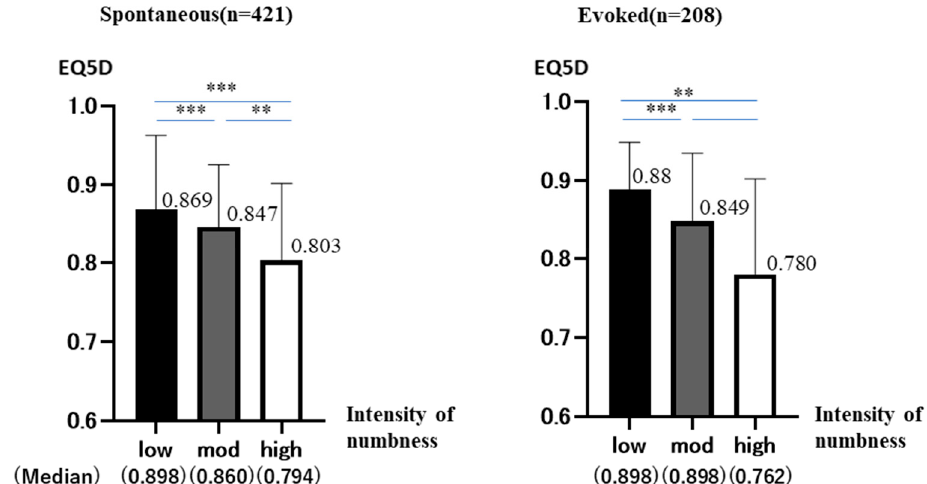
Figure 2. Each type of numbness was analyzed separately as Spontaneous and Evoked. EQ5D is on the vertical axis, and the intensity of numbness is on the horizontal axis. The graph shows the mean and standard deviation (95%CI) of EQ5D in each group ( p < 0.01 **, <0.001